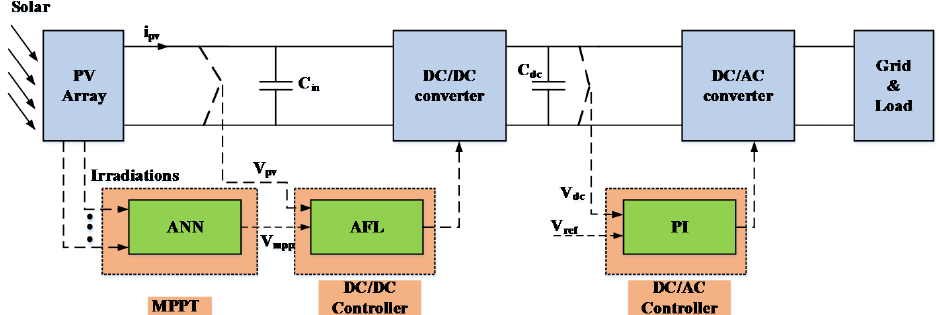
Figure 1. Structure of a PV (photovoltaic) system with a classical MPPT (maximum power point tracking) ‐ based ANN (artificial neural network).